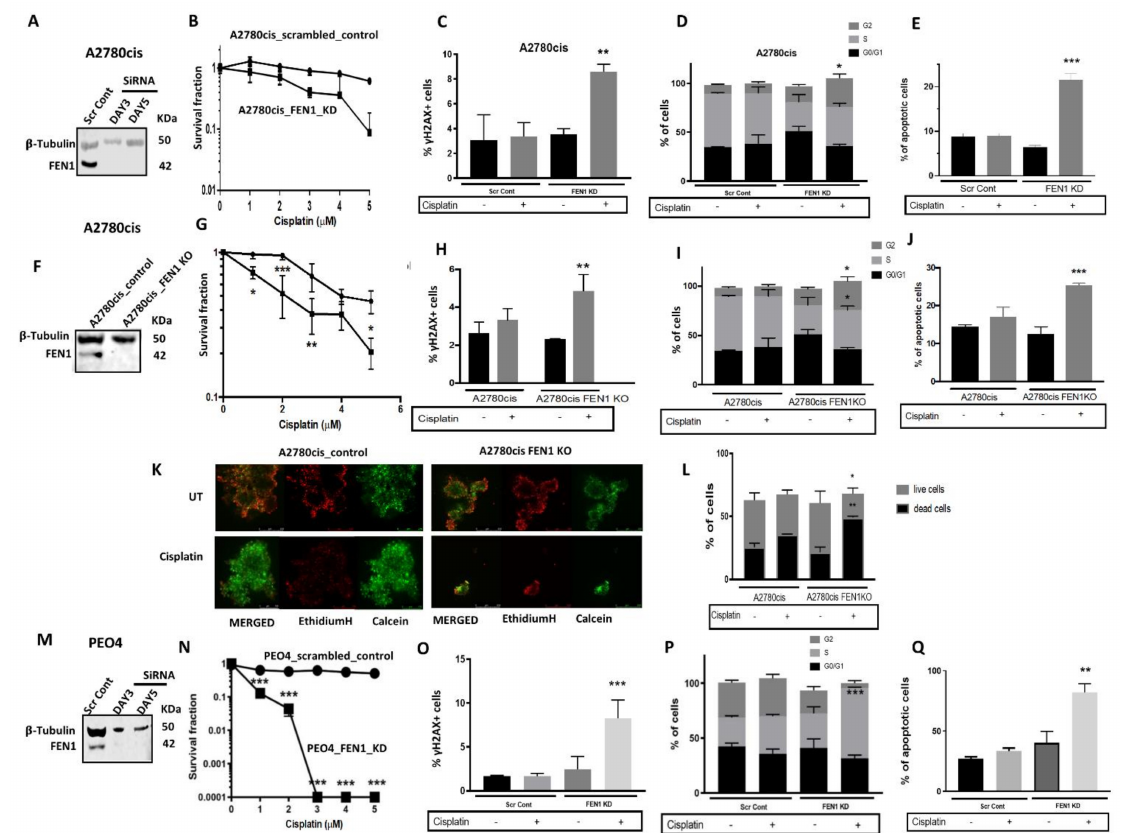
Figure 3. ( A ) FEN1_KD in A2780cis cells. ( B ) Cisplatin sensitivity in A2780cis control and A2780cis_FEN1_KD cells. ( C ) Quantification of γ H2AX nuclear fluorescence by ImageJ software. ( D ) Cell cycle analysis by flow cytometry ( E ) Annexin V analysis by flow cytometry. ( F ) FEN1_CRISPR_KO in A2780cis cells. ( G ) Cisplatin sensitivity in A2780cis control and A2780cis_FEN1_KO cells. ( H ) Quantification of γ H2AX nuclear fluorescence by ImageJ software. ( I ) Cell cycle